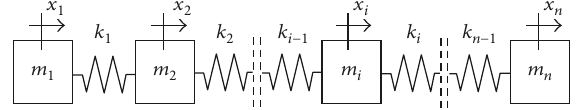
Figure 5: The lumped model of the